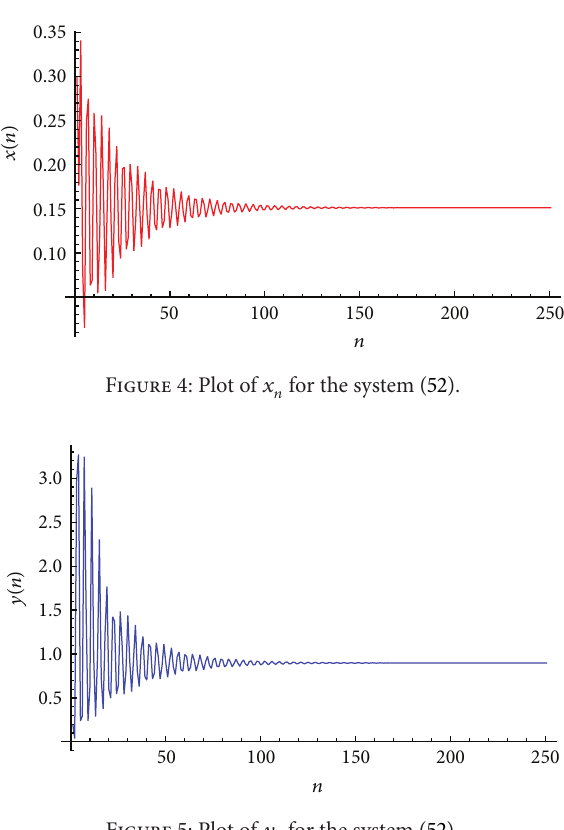
Figure 5: Plot of 𝑦 𝑛 for the system